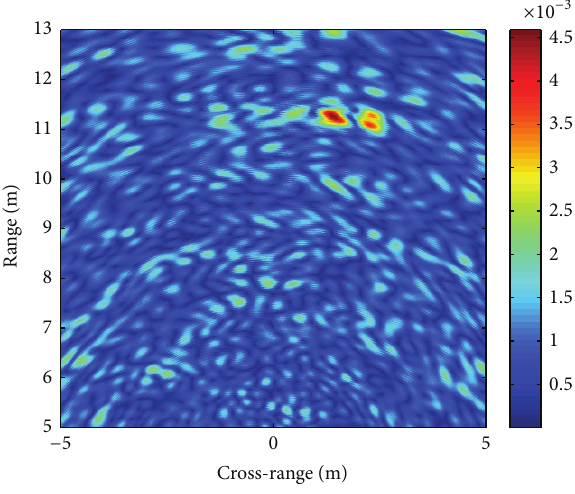
Figure 21: The original imaging result of the trihedral. In the figure, target has strong sidelobes.